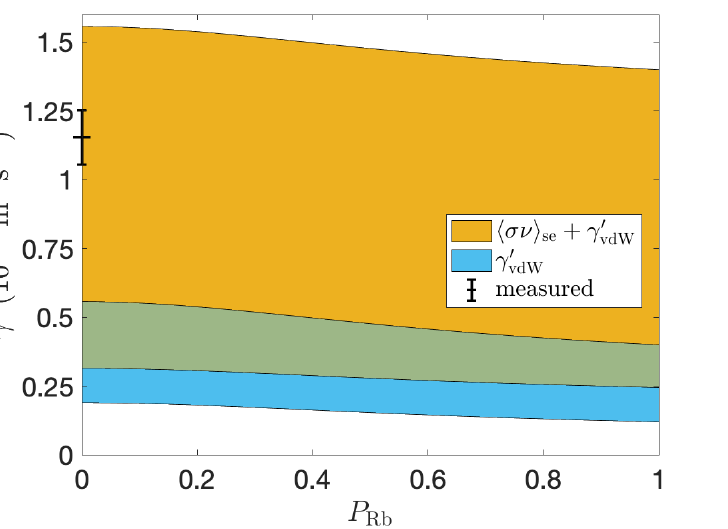
(cid:38) 5 × 10 17 m − 3 , which is our current limit of D 1